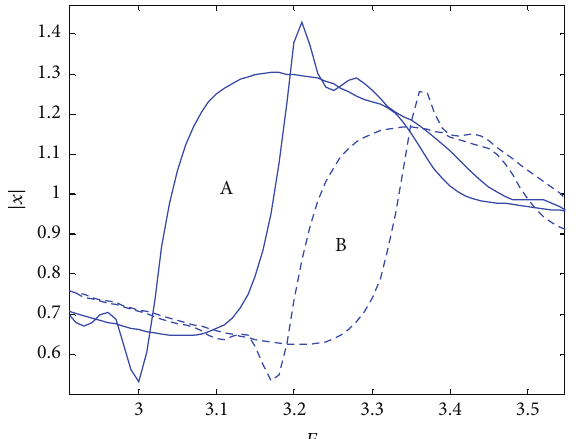
Figure 11: Local amplification of bistable region.